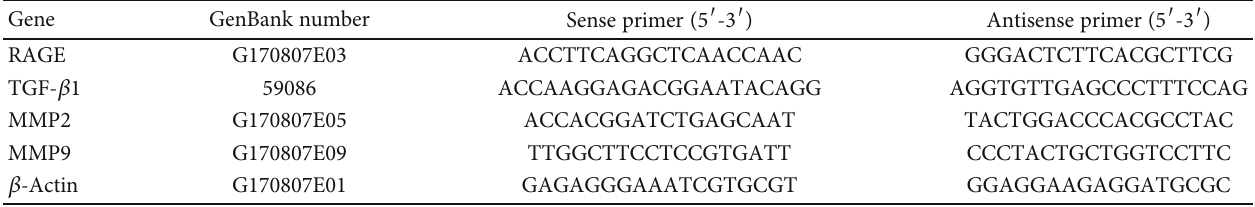
Table 1: The rat primer sequences used in this